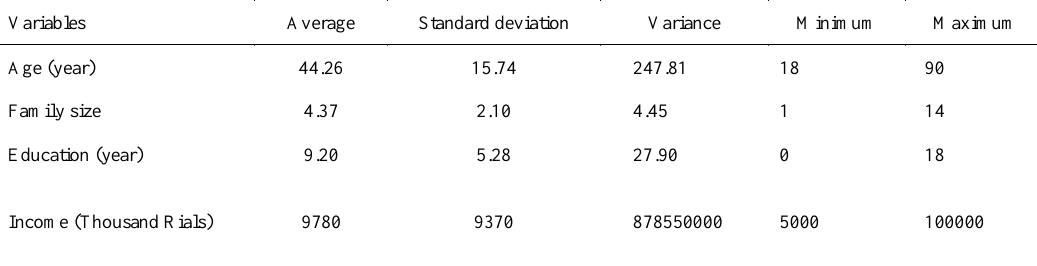
Table 1: Summary of the descriptive statistics for the